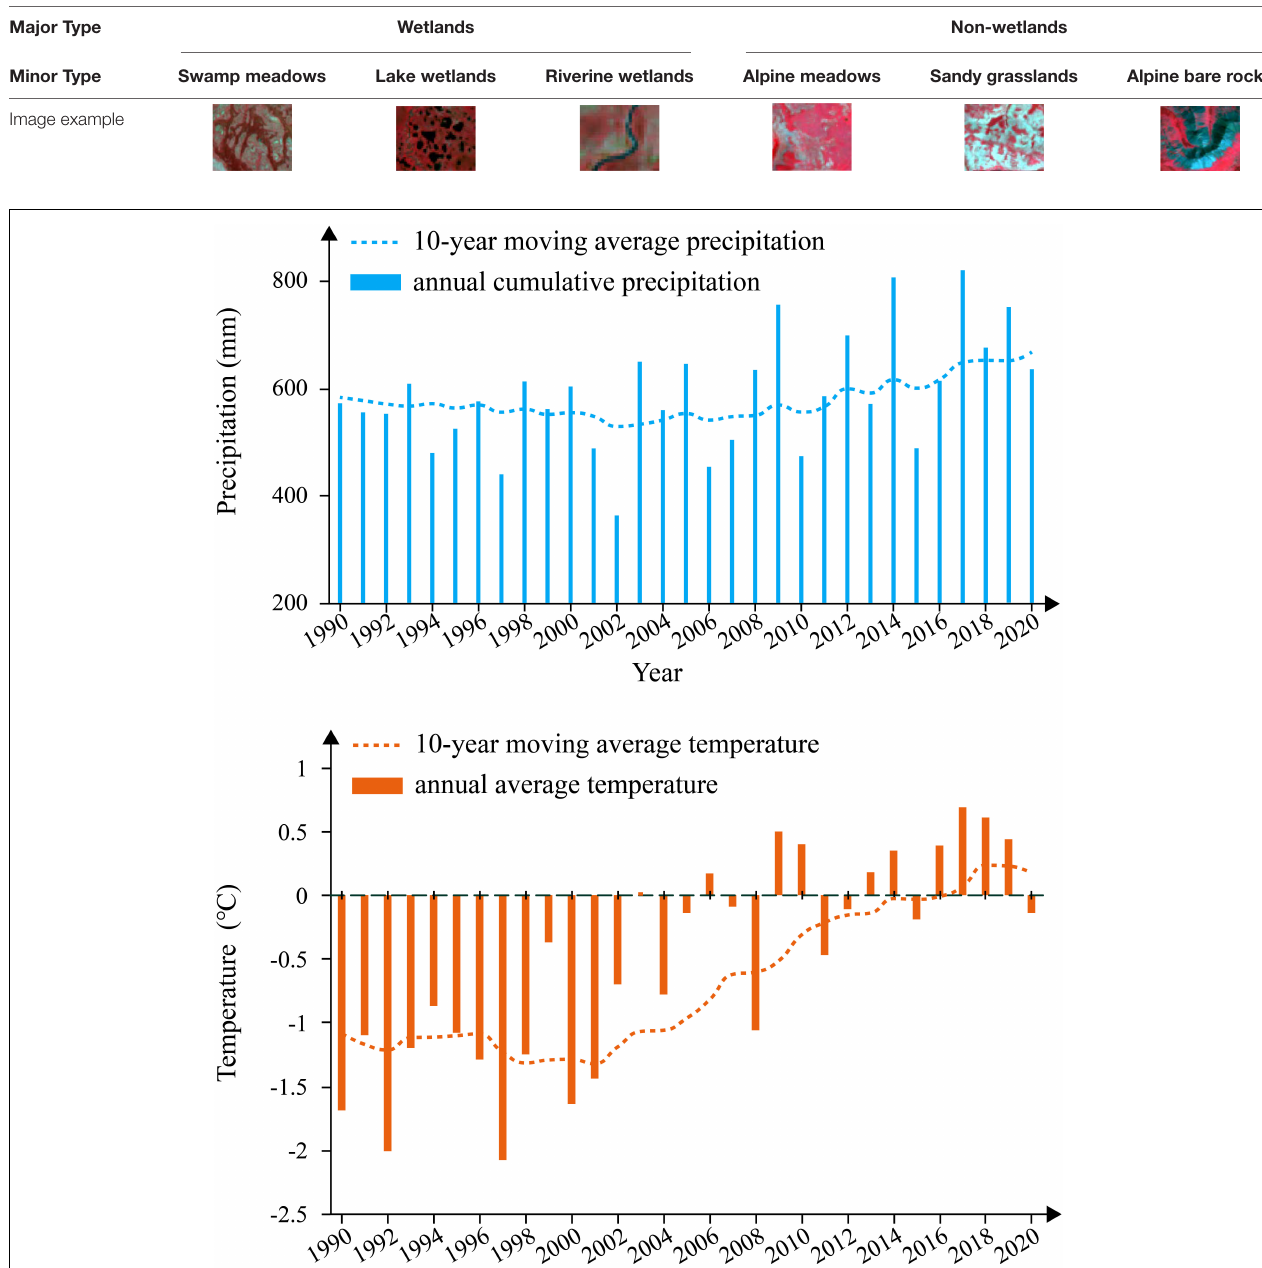
TABLE 2 | Image example of landscape type.